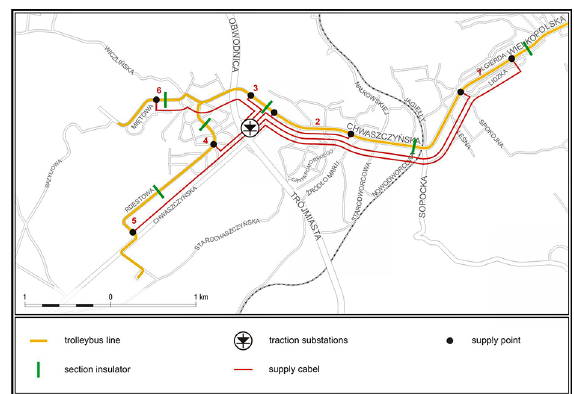
Fig. 2. Example of centralized supply system